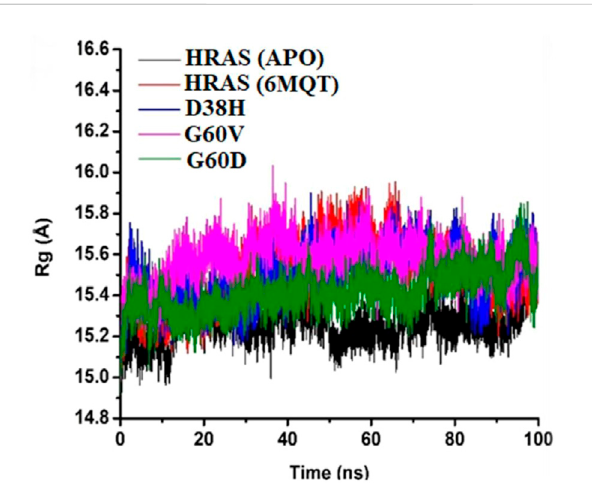
FIGURE 9 The protein Structure ’ s Stability throughout Simulation Time